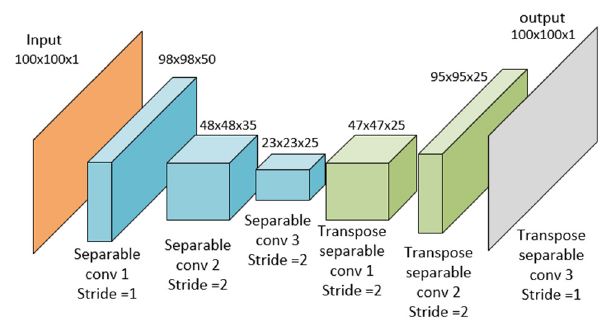
Figure 3. The neural architecture of the autoencoder.